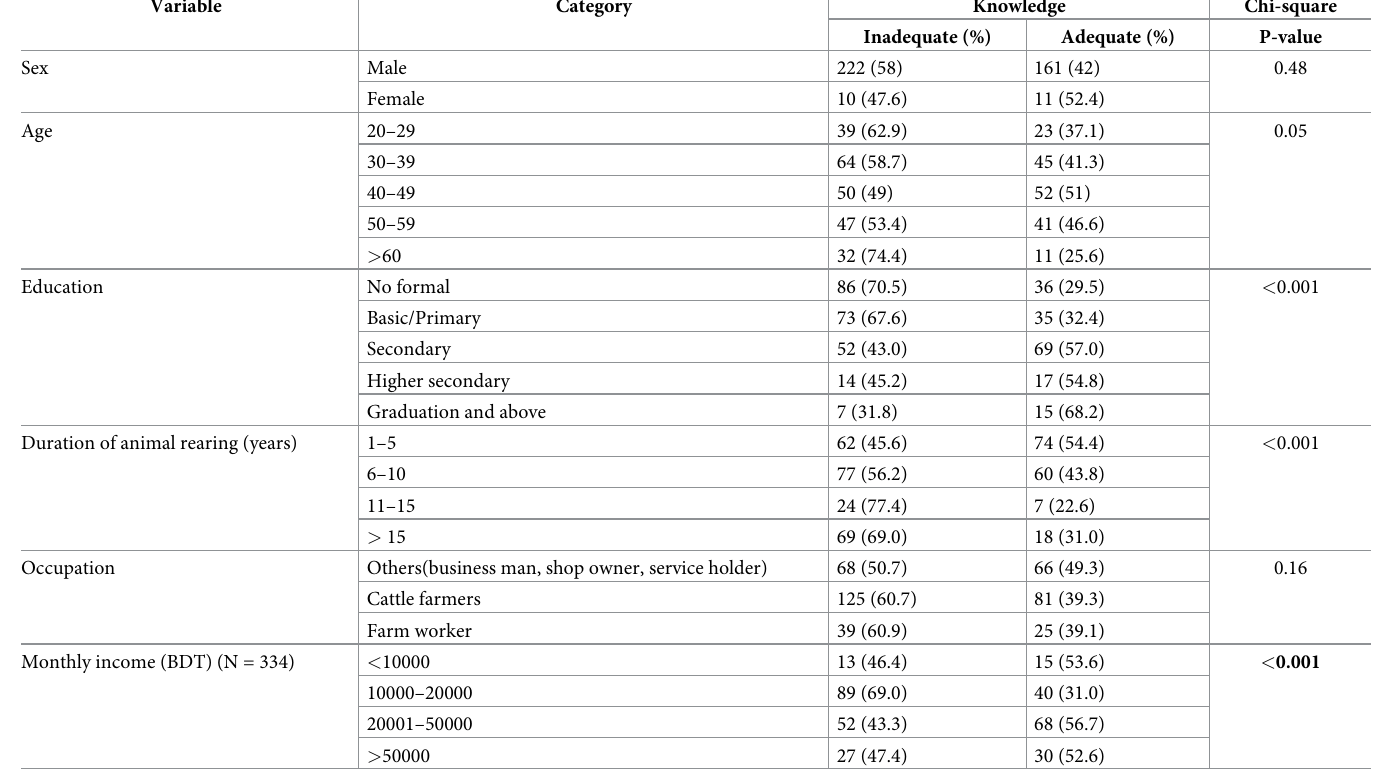
Table 2. Association between cattle handlers’ demographics, socioeconomic characteristics and overall knowledge of zoonotic tuberculosis in the selected districts of